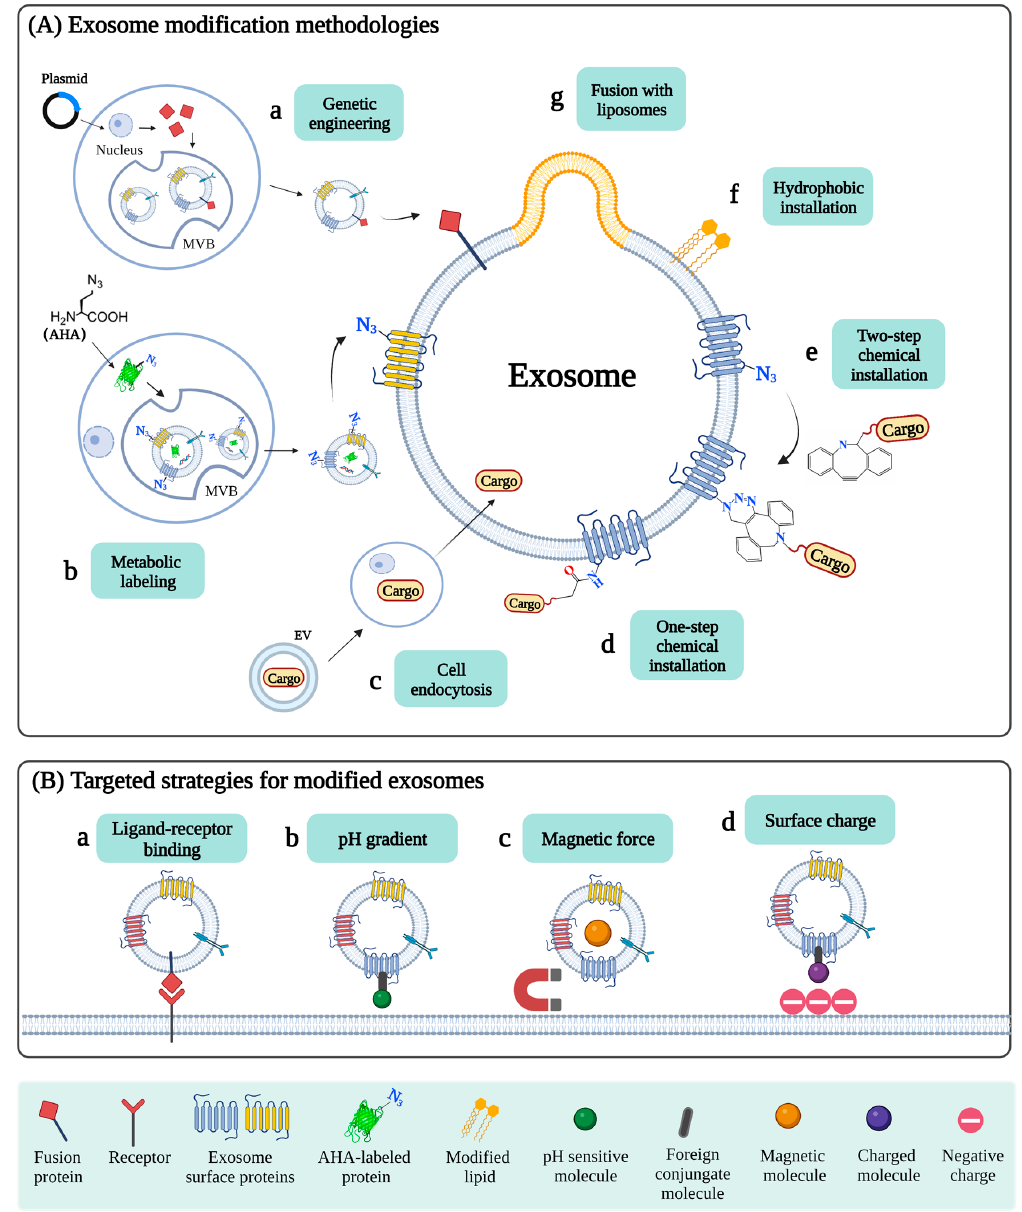
Figure 2. Overview of exosome modification and targeted delivery. ( A ) Exosome modification methodologies. There are a number of approaches to modifying exosomes to achieve targeted delivery in practical applications. Exosomes can be engineered before they are isolated, by expressing fusion proteins on the exosomal surface ( a ). In addition, exosomes bearing functional groups, such as azides, can be produced by incubating the donor cells with azide-labeled metabolites ( b ). The azide-labeled exosomes can be further functionalized through either physical or chemical modification. Exogenous material can be introduced to exosomes by the endocytosis and exocytosis of the parent cells ( c ). Chemical installation of simple molecules can be achieved by direct reaction with amino acid side chains of exosomal membrane proteins ( d ). To install complicated molecules, azide groups are first introduced to the exosomal membrane. The cargos can be conjugated to dibenzobicyclooctyne (DBCO) and then introduced to the exosomal surface by strain-promoted azide-alkyne click reaction (SPAAC) ( e ). Physical modification can be applied by hydrophobic insertion ( f ) or fusion with liposomes ( g ). ( B ) Targeted strategies for modified exosomes. Engineered exosomes are guided to targeted cells through ligand-receptor-specific binding, magnetic force, pH gradient, and surface charge attraction.